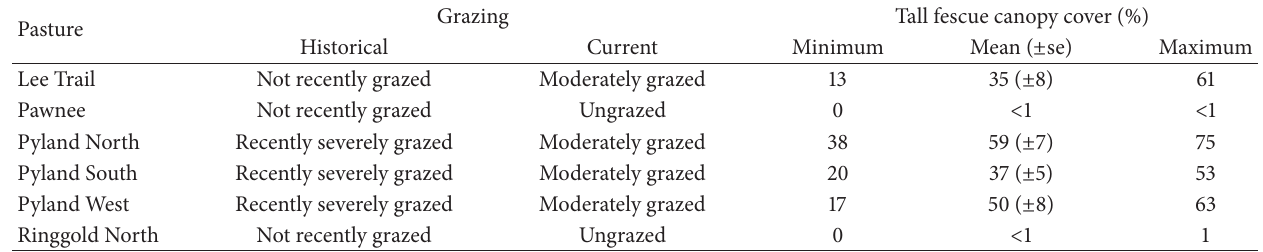
Table 1: Summary of historical (2000–2006) and 2010 grazing management information and tall fescue abundance (as percent canopy cover) forsixpasturesintheGrandRiverGrasslandsofRinggoldCounty,IA,andHarrisonCounty,MO,USA.Severegrazingreferstoapproximately 15 animal unit months/ha